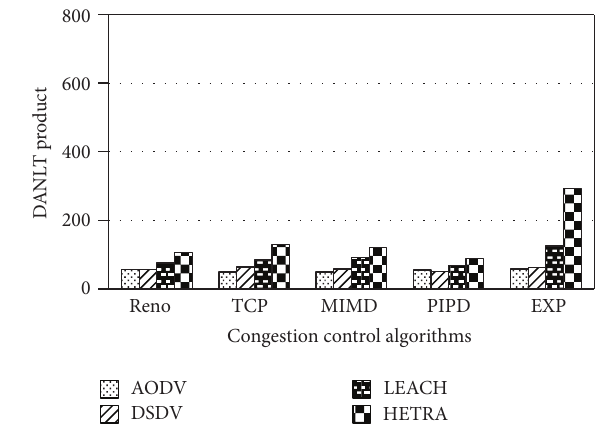
Figure 9: DANLT product for Pattern 2.